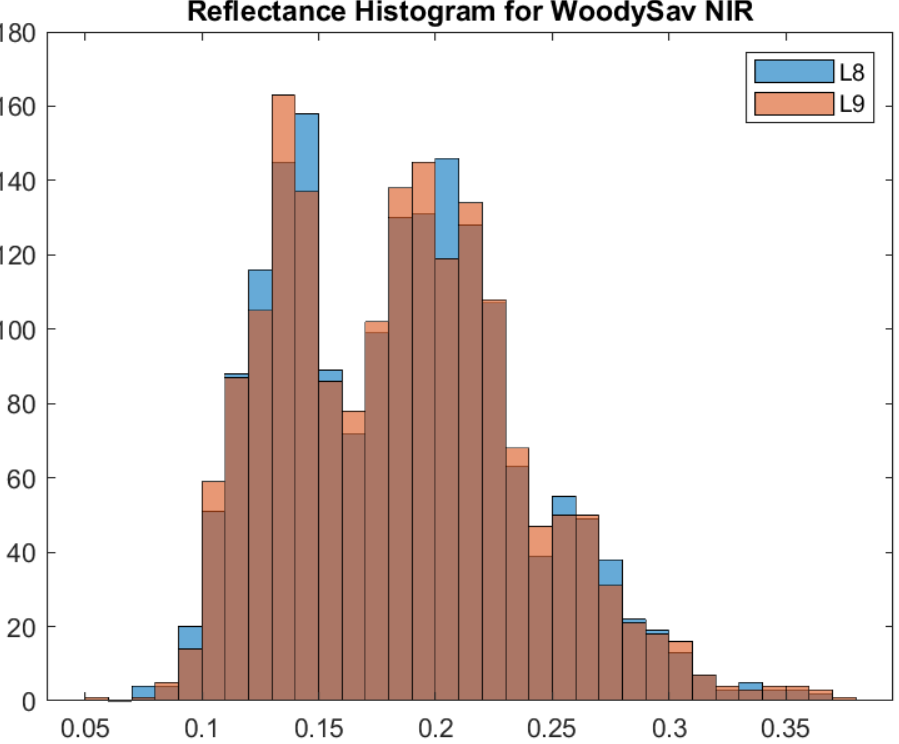
Figure 4. Woody Savanna IGBP global NIR band reflectance distribution. Note the two peaks in the distribution.